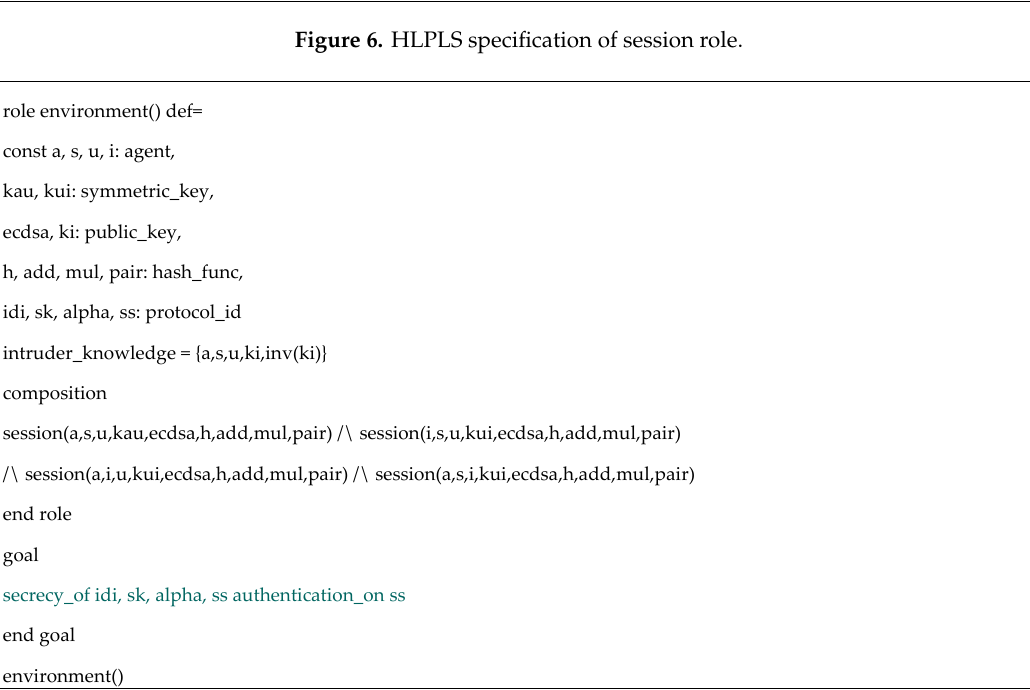
Figure 7. HLPLS specification of environment role.